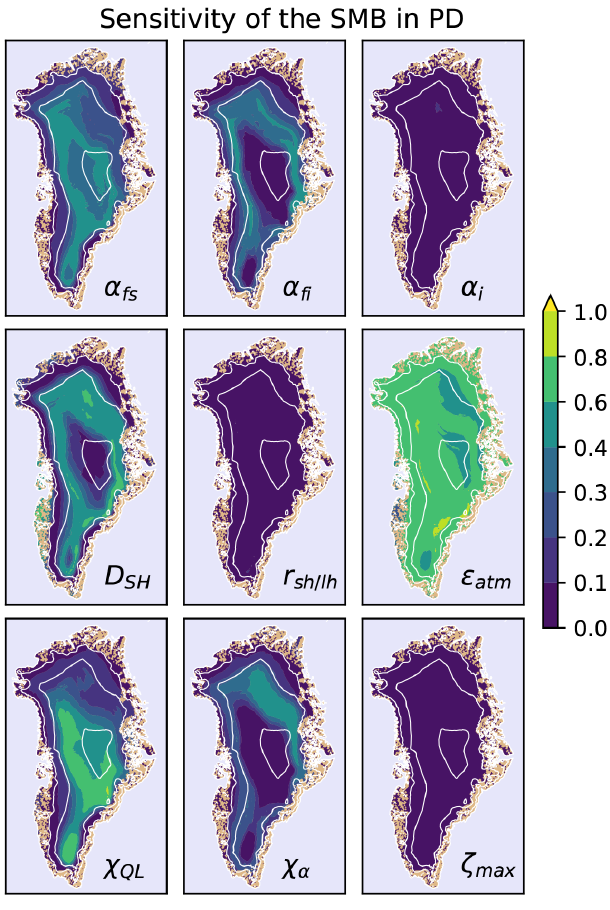
Figure 4. Global Sensitivity in the LGM. The total sensitivity index of the SMB of every parameter for the PD is displayed for every ice- covered grid cell. The ice-free land is in brown; the ocean is in light blue; 1000m contours are in white. The total sensitivity index of the surface mass balance for the LGM is more variable than during the PD. The model shows the greatest sensitivity towards χ Q and the atmospheric emissivity (cid:15) atm followed by the fresh snow albedo α fs . Firn albedo α fi and the albedo module χ α as well as the tur- bulent exchange coefficient D SH are important around the margin. The SMB during the LGM shows almost no sensitivity towards the other